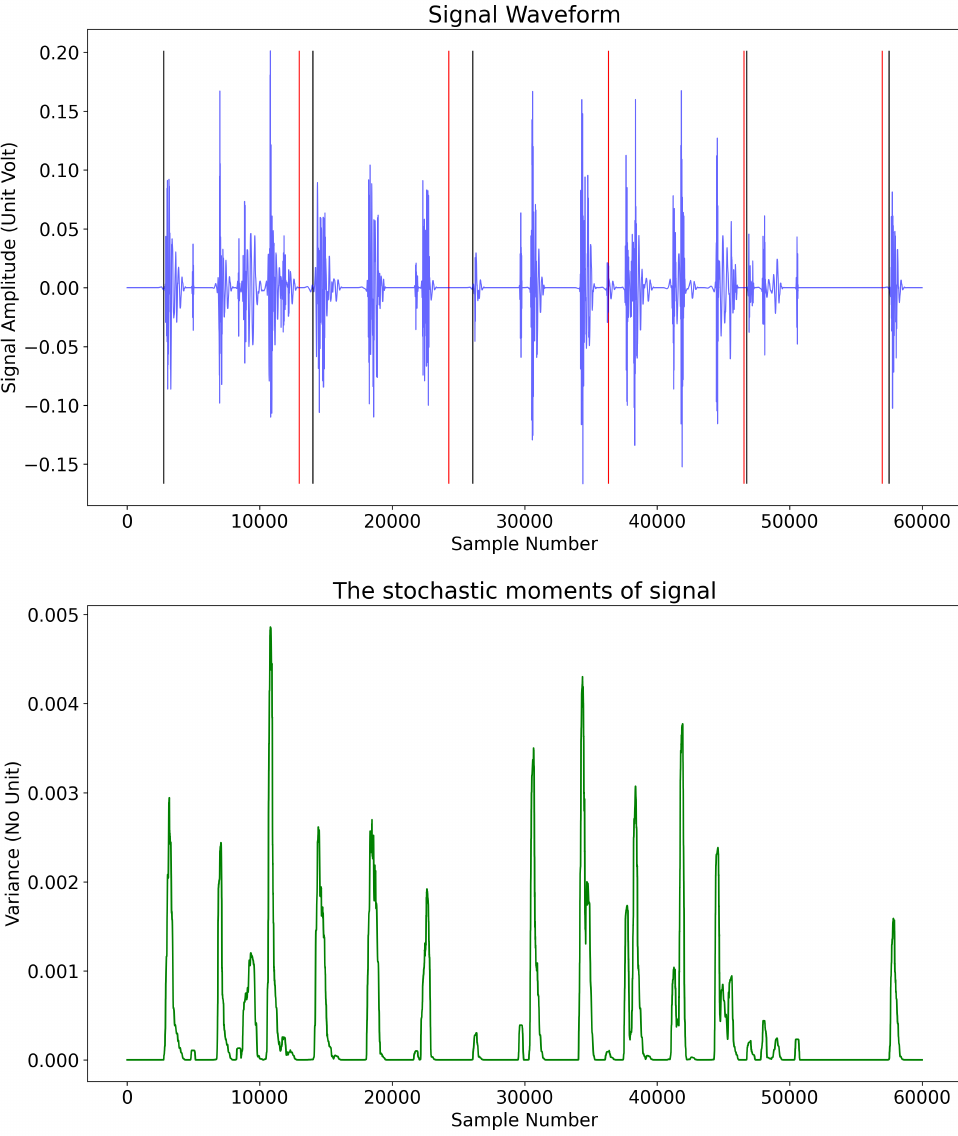
Figure 7. An example of signal selection and event detection from the signal stream. The black solid lines denote the beginning of each input sample and red lines the